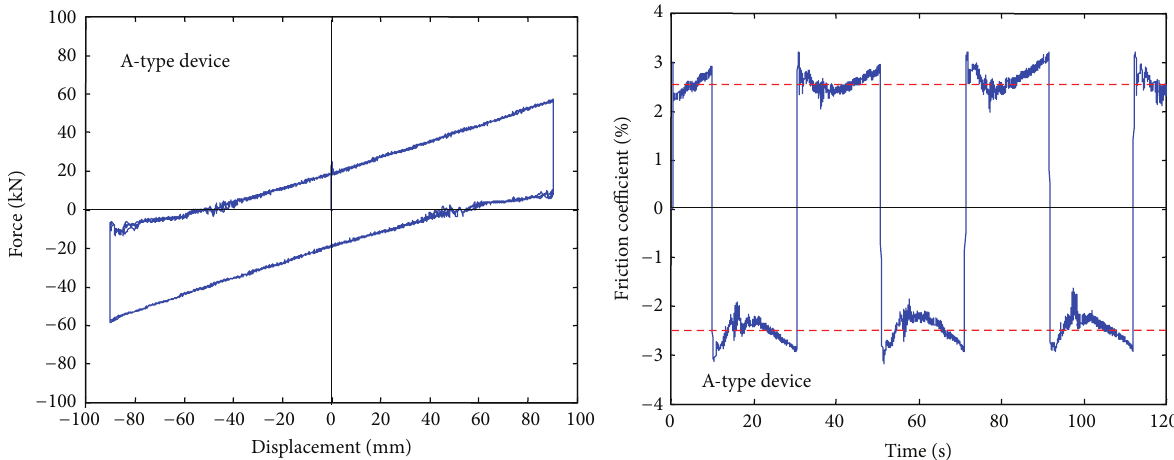
Figure 7: Response cycles and portion of the friction coefficient time-history obtained from a dynamic test carried out on one A-type isolator, = ±91 mm, V = 10 mm/s, and 𝑉 = 900 kN. with 𝑑 c , max d